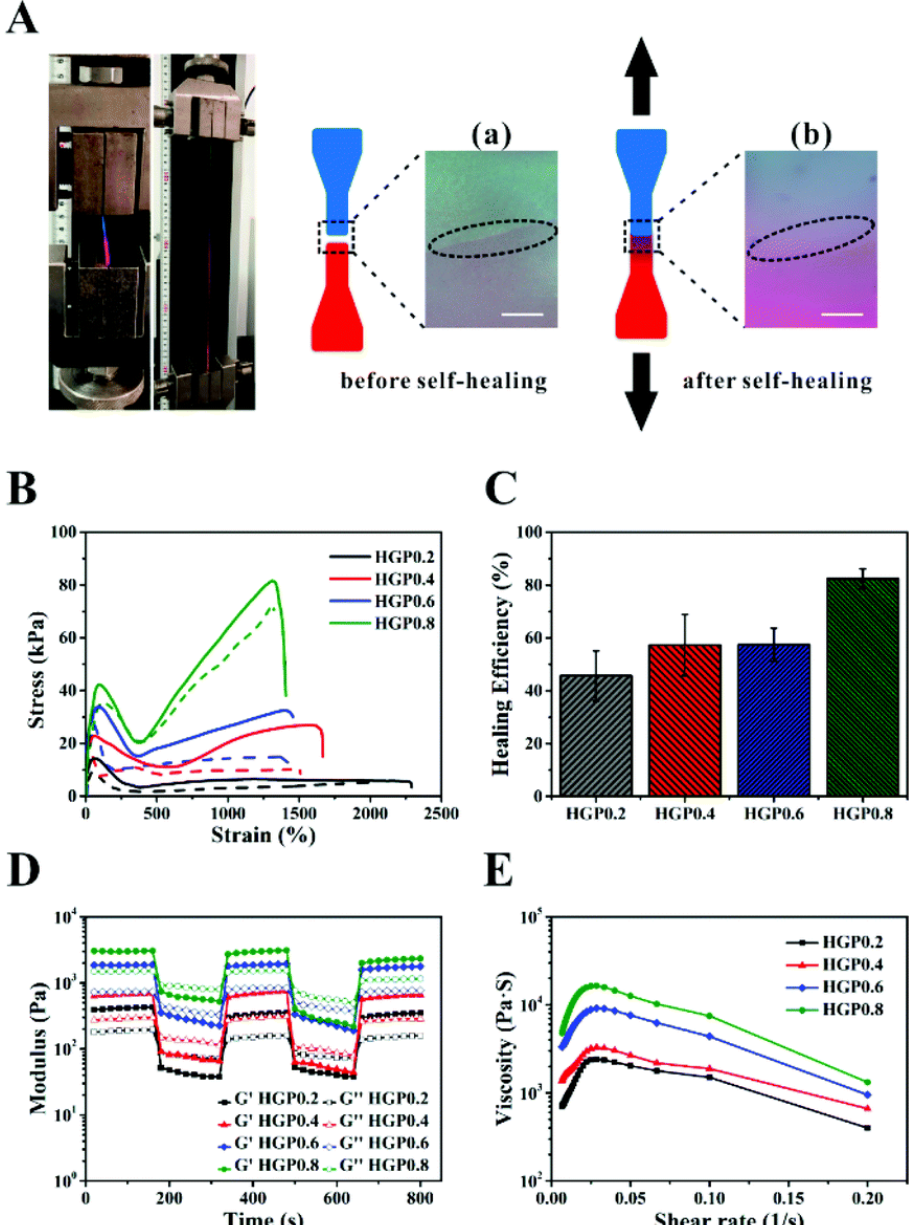
Figure 35. Self-healing and shear thinning properties of HGP hydrogels: ( A ) optical microscopy im- ages of samples before and after self- healing (scale bar: 500 μm); ( B ) stress – strain curves of the HGP hydrogels (― original and −−− self -healed) with different content of POSS; ( C ) the self-healing effi- ciency based on rupture energy; ( D ) amplitude oscillatory sweep (1% strain – 500% strain – 1% strain); ( E ) shear stress of the HGP hydrogels loading a shear rate sweep. Reproduced from Biomater. Sci. 2020, 8 , 3359 – 3369 [105] with permission from the Royal Society of Chemistry.